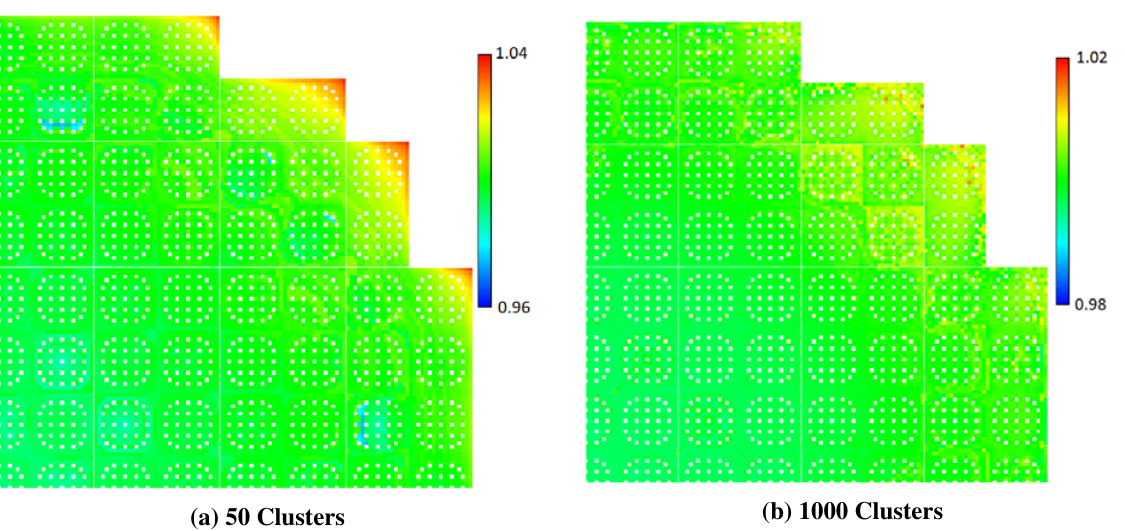
Figure 3: Ratio of PFD using 50 and 1,000 clusters to the reference